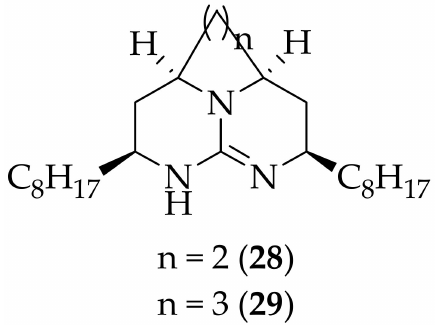
Figure 17. Antifungal derivatives ( 28 ) and ( 29 ) of batzelladine K.